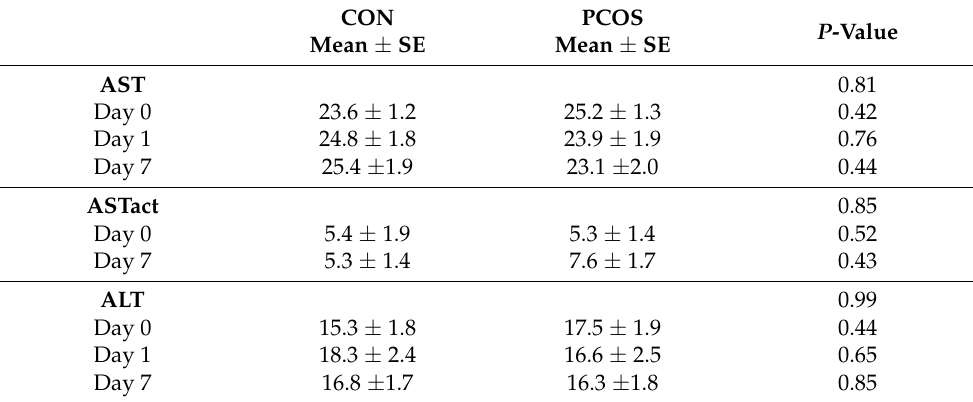
Values are baseline, Day 1, and Day 7 measurements. An analysis of covariance with body fat percentage used as the covariate was used to distinguish differences between CON ( n = 15 for ALT, and AST; n = 6 for ASTact) and PCOS ( n = 14 for ALT, and AST; n = 6 for ASTact). No significant differences were observed between groups or across the days for each. ALT = alanine aminotransferase; AST = aspartate aminotransferase; ASTact = aspartate aminotransferase activity; CON = control group; PCOS = polycystic ovary syndrome